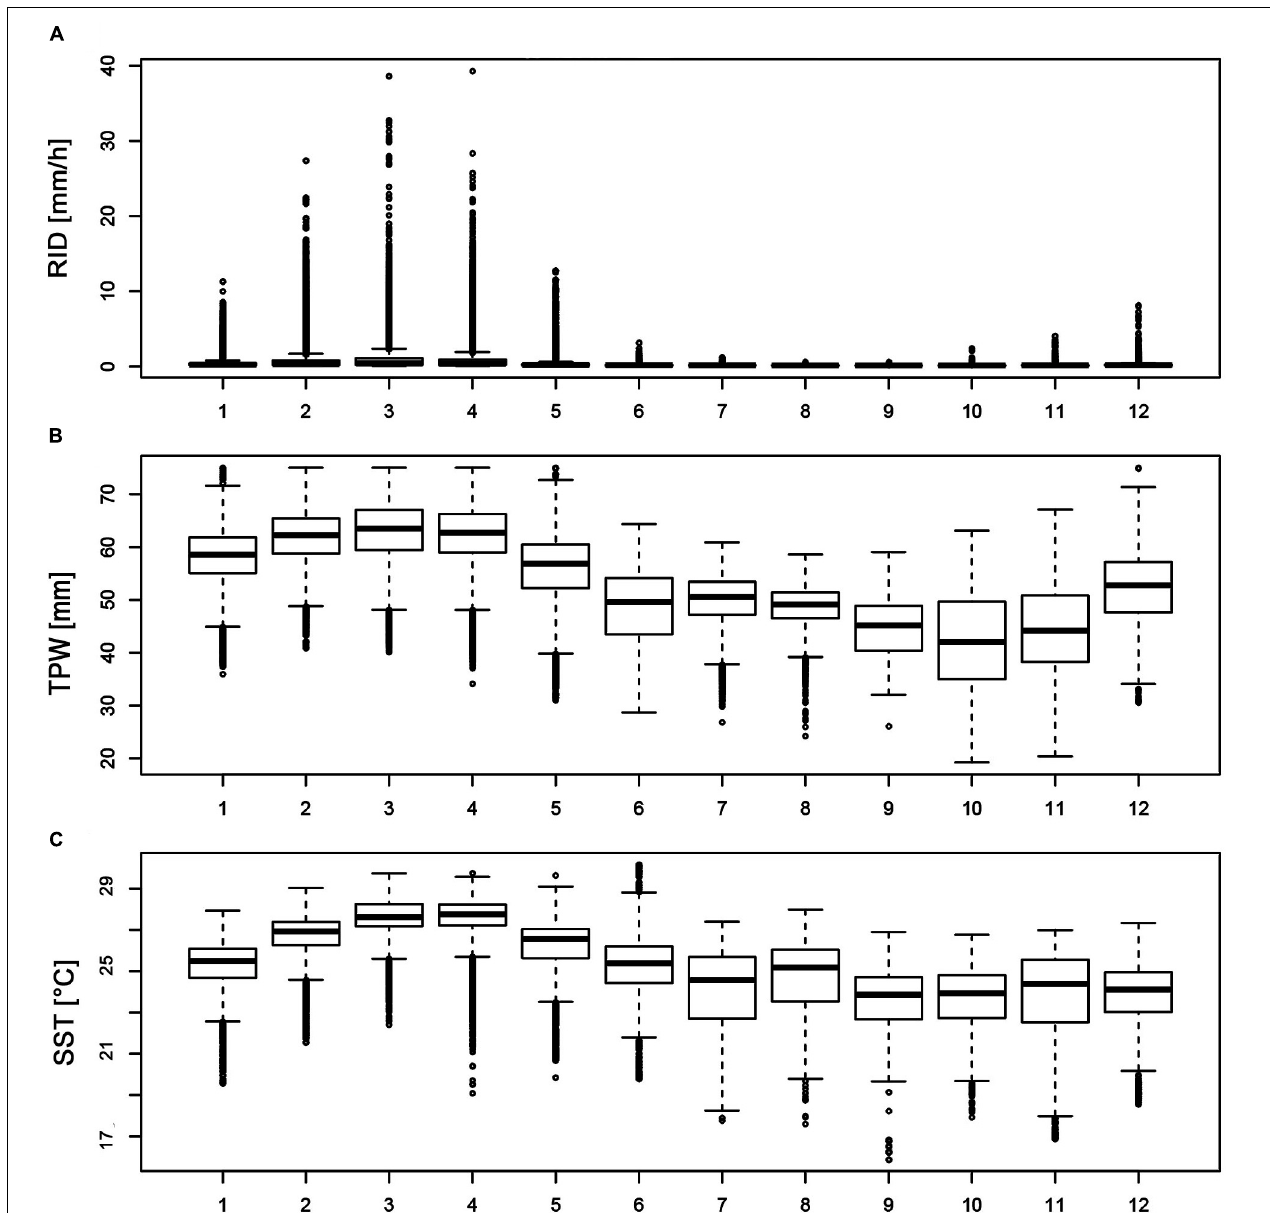
FIGURE 2 | Monthly boxplot analysis for (A) RID, (B) TPW, and (C) SST. The rainy season extends from February to April and the dry season extends from August to